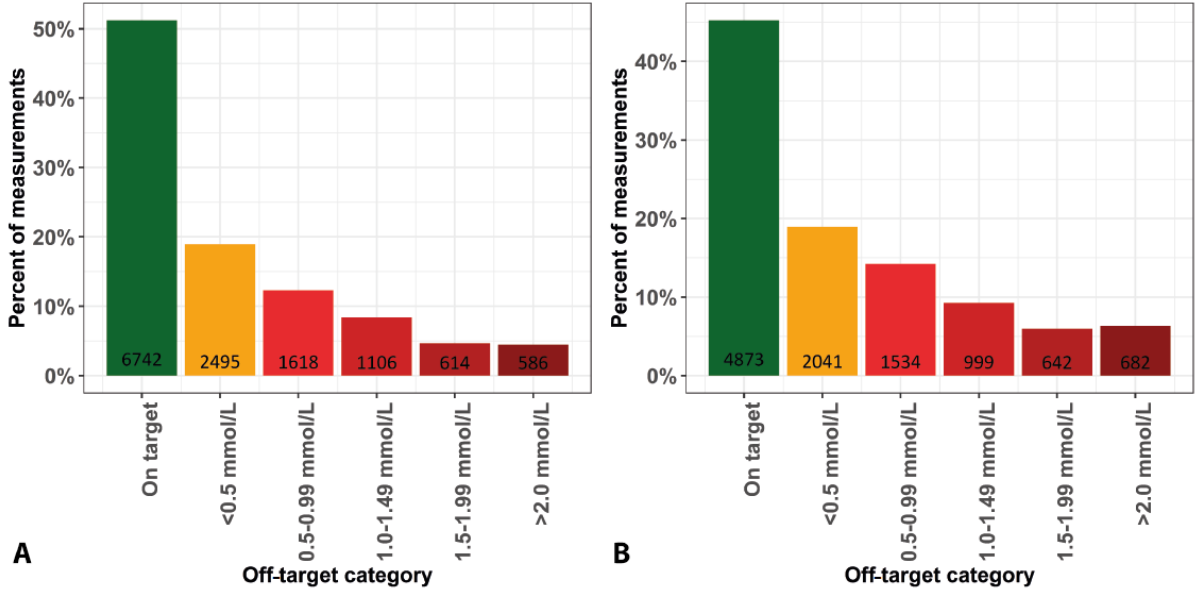
Figure 3. Low-density lipoprotein cholesterol distributions stratified for patients with and without repeated measurements. A. Patients without repeated measurements. B. Patients with repeated measurements. Values on the x-axes represent mmol/L from the target.